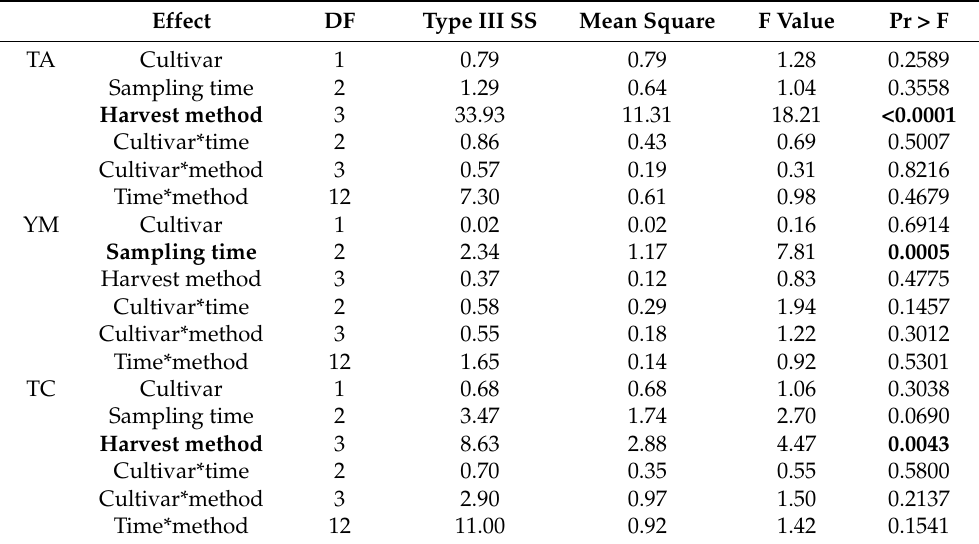
Table 1. Results of the type III tests for fixed effects by the statistical model of blueberry harvesting ( α = 0.05).